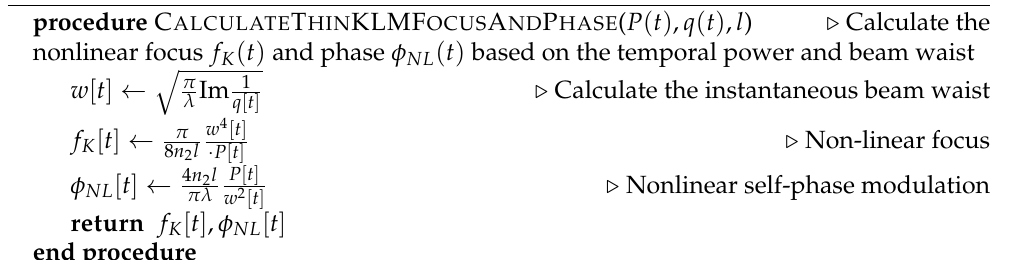
Algorithm A3 Procedures for non-linear loss and gain (diffraction and